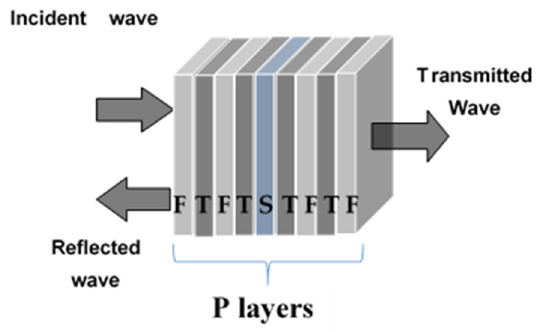
Figure 1. Schematic representation showing a periodic photonic crystal with the middle cavity containing the seawater, where F is the fused silica layer, T is the TiO 2 layer and S is the seawater